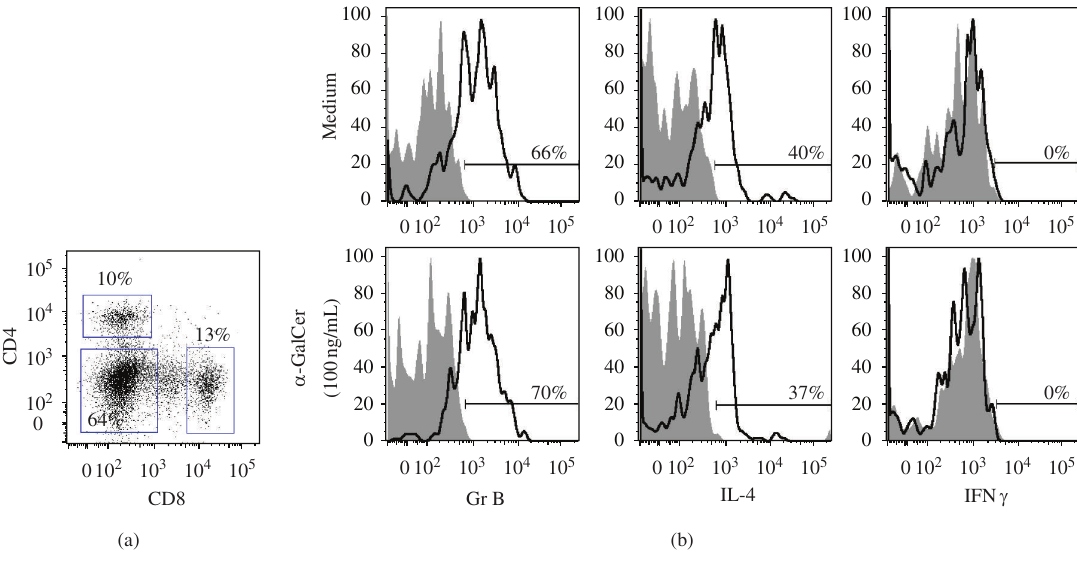
FIGURE 2: Phenotype of expanded iNKT cells. (a) PBMCs cultured for 7 days with α -GalCer in combination with rhIL-2 and rhIL-7 followed by FACS-based cell sorting for CD3 + V α 24 + cells. Sorted iNKT cells were cultured with allo-PBMCs feeders, anti-CD3 mAb, and rhIL-2 and rhIL-7 for 21 days. (b) Cytokine profile of expanded (day 28) iNKT cells. Cellular cultures of FACS-sorted/expanded CD3 + CD4 neg V α 24 + cells were stimulated for 5 hours with media alone or media + α -GalCer. Samples were analyzed using BD LSRII equipment and FlowJo 9.3.2 software. GrB : intracellular Granzyme